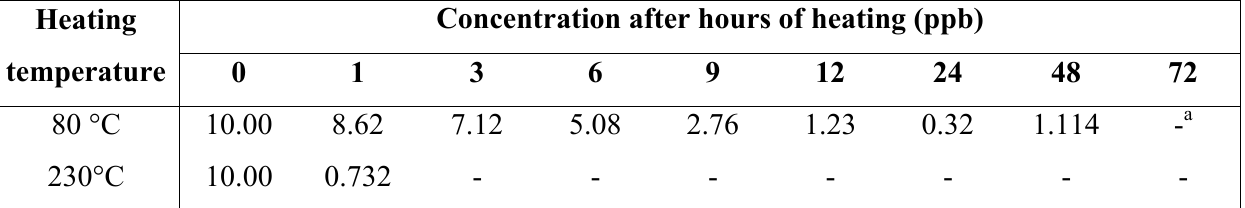
Table 4. The degradation of OLP from 0 to72 hours at 80 and 230